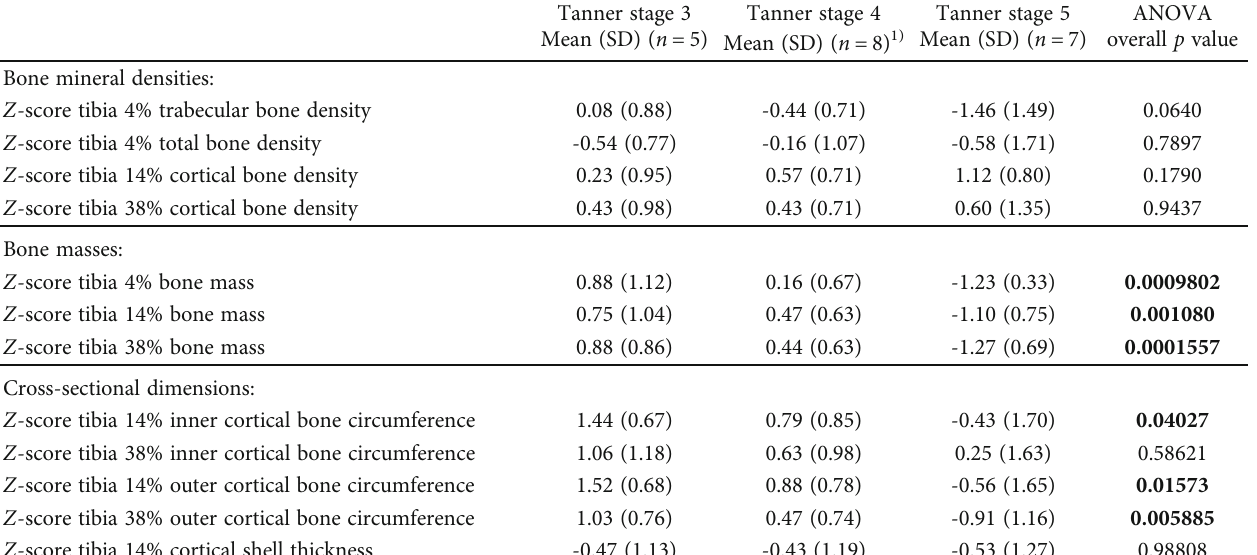
Table 5: Z -scores of pQCT outcomes by Tanner stage in